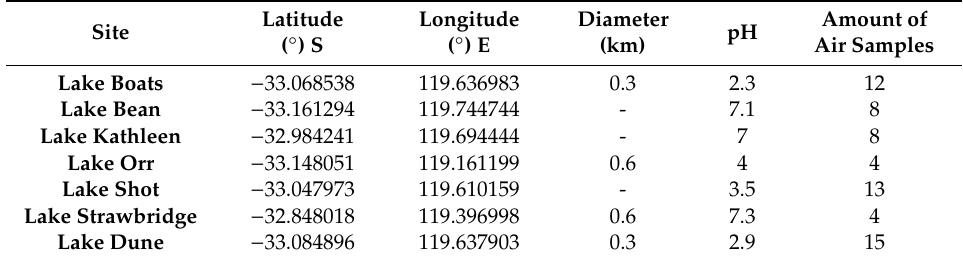
Table 1. Overview of the sampling sites with position, diameter, pH of lake water, and amount of air